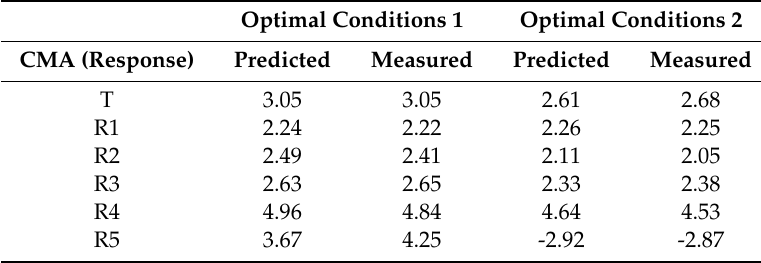
Table 6. Final chromatographic conditions for the UHPLC method developed.